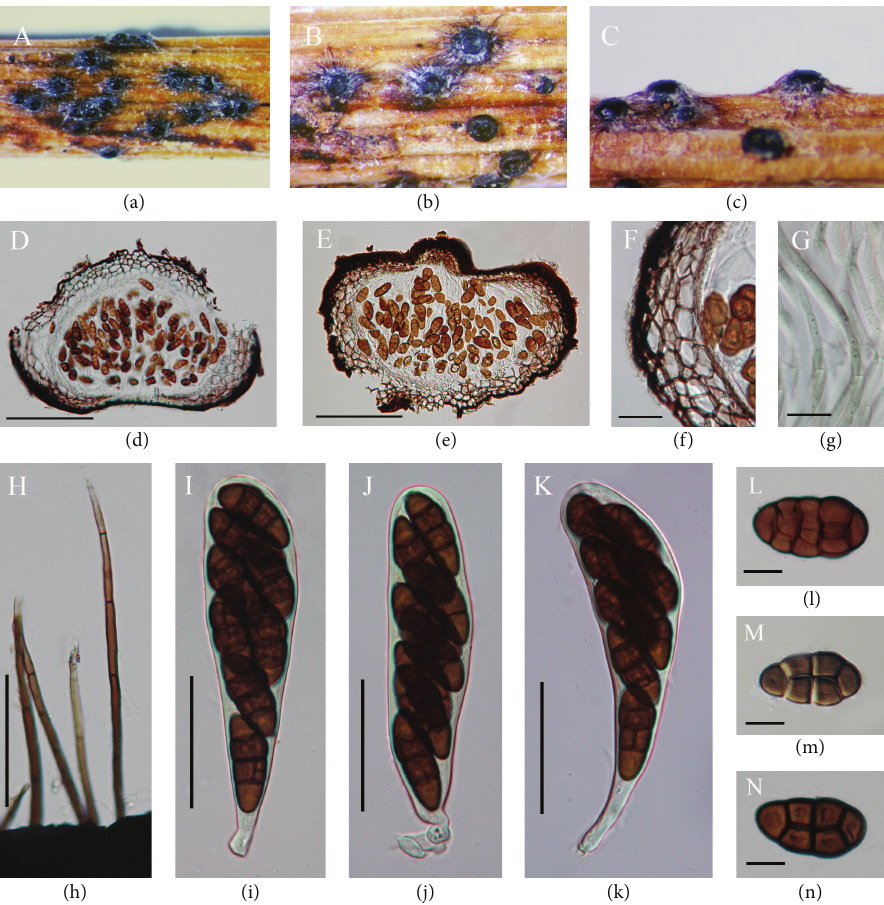
Figure 4: Diademosa californiana (holotype). ((a)-(b)) Ascomata on host substrate. (c) Side view of the ascomata. ((d)-(e)) Section of ascomata. (f) Section of peridium. (g) Septate, hyaline, and cellularpseudoparaphyses. (h) Light to dark brown seta. ((i)–(k)) Ascus with minute pedicel bearing irregularly arranged 8 ascospores. (l)–(n) Ascospores. Scale bars: ((d)-(e)) = 200 𝜇 m, ((f)–(h)) = 10 𝜇 m, ((i)–(k)) = 50 𝜇 m, and (l)–(n) = 10 𝜇